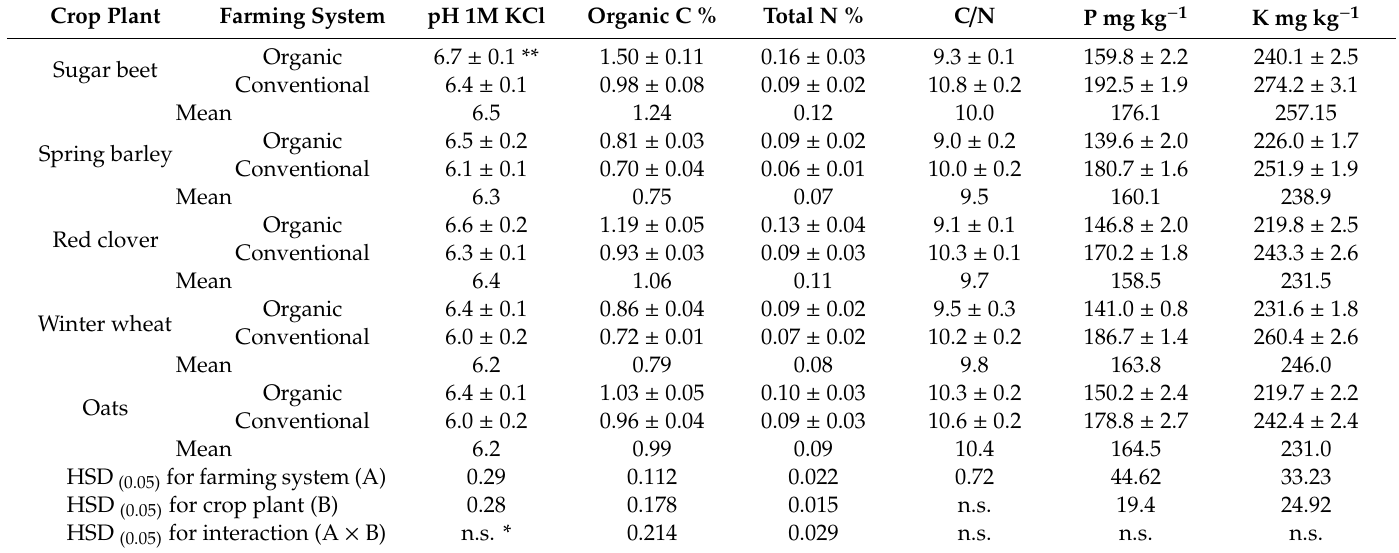
Table 5. Selected soil chemical components (0–20 cm profile)—mean for